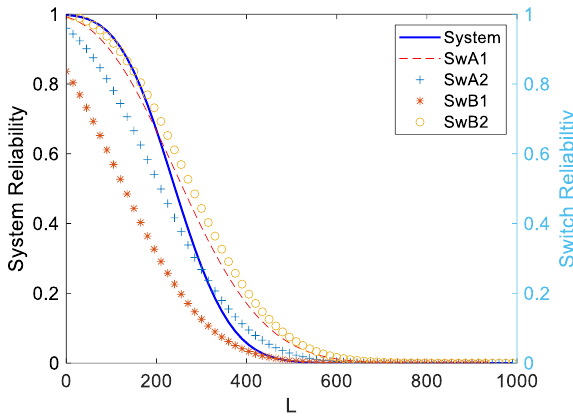
Figure 13. Set 2 in Table 10 ( L SwA10 = 50 , L SwA20 = 100 , L SwB10 = 180 , and L SwB20 = 30 and α= 2.5).